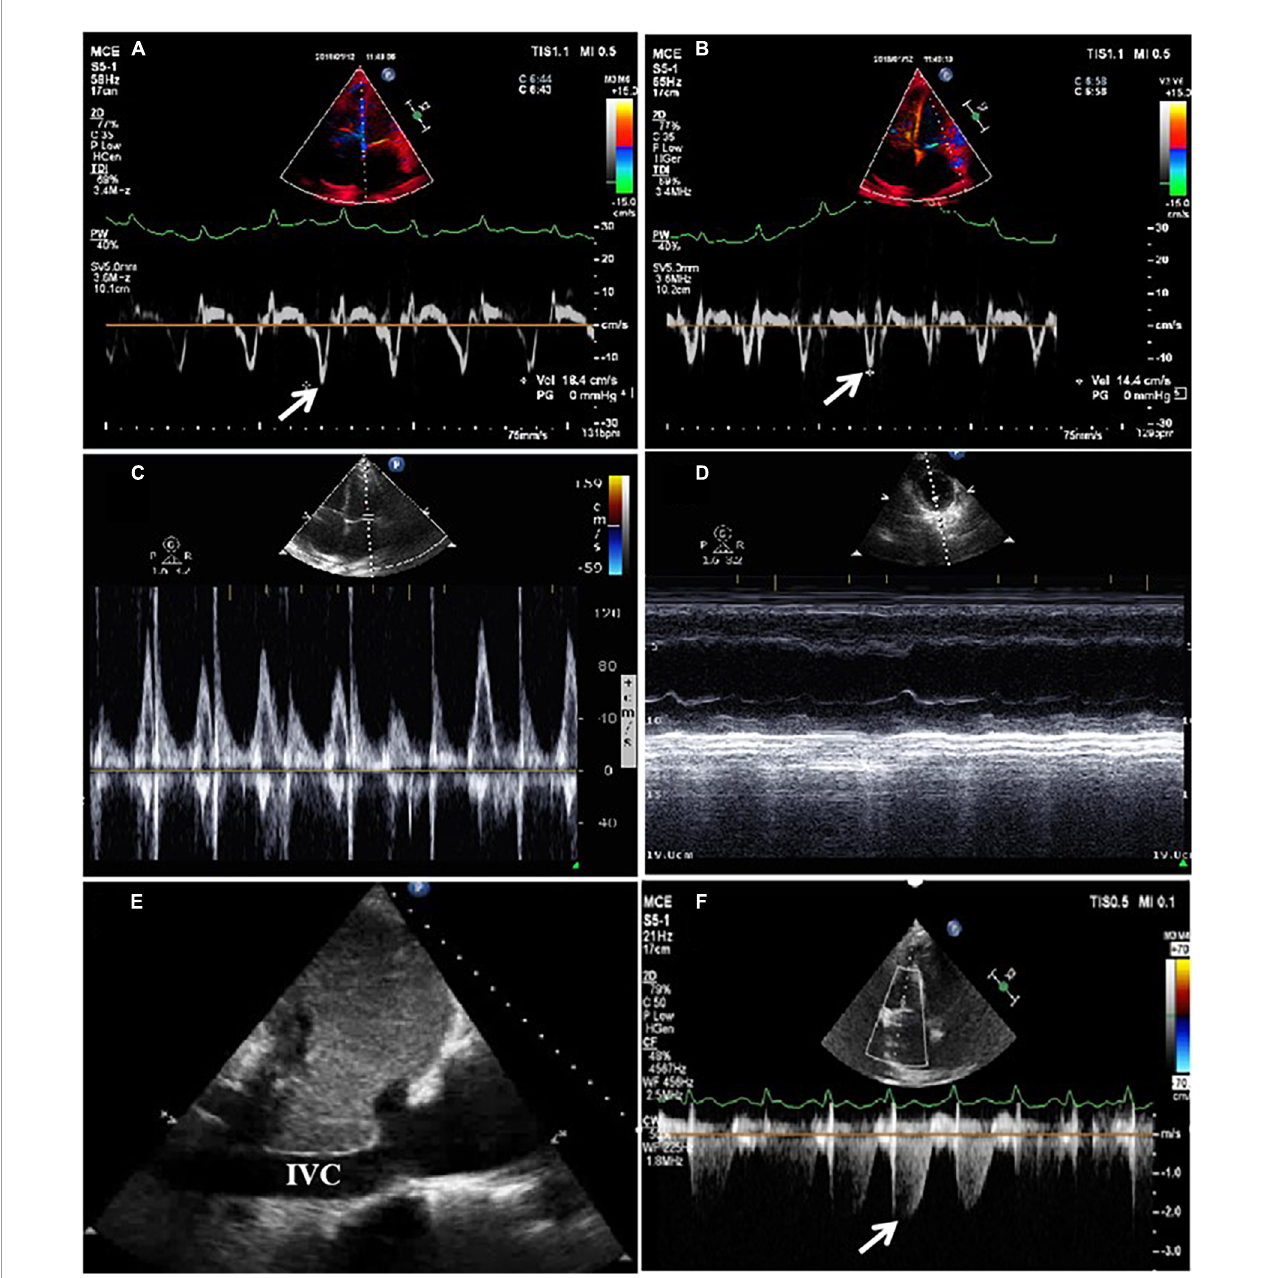
FIGURE2 Tissue Doppler imaging (TDI) using echocardiography revealed that e’ = 18.4 m/s (medial) > 14.4 m/s (lateral) in the mitral valve (A,B) . Significant respiratory variation of mitral or tricuspid peak E velocity was indeterminable due to atrial fibrillation (AF) (C) . Paradoxical septal motion during respiration was not observed (D) . The inferior vena cava (IVC) was dilated without inspiratory collapse (E) . Pulmonary artery pressure was elevated according to the velocity of tricuspid regurgitation (F)